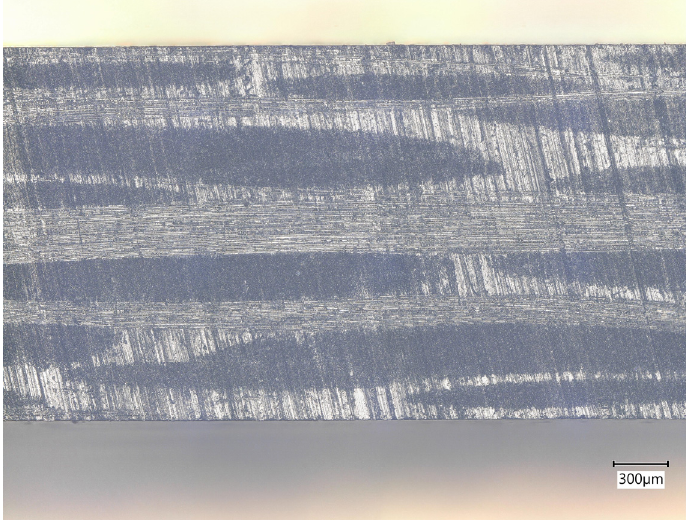
Figure 1. An optical microscopic image of a CFRP sheet of 2 mm in thickness supplied by Easy Composite Ltd.